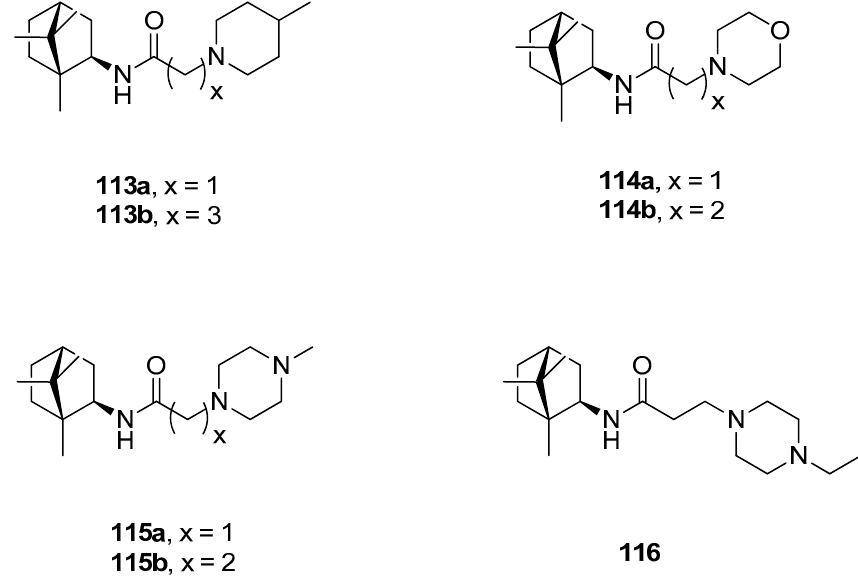
Figure 29. (+)-Camphor amide derivatives with the heterocyclic fragment. Figure 29. ( + )-Camphor amide derivatives with the heterocyclic